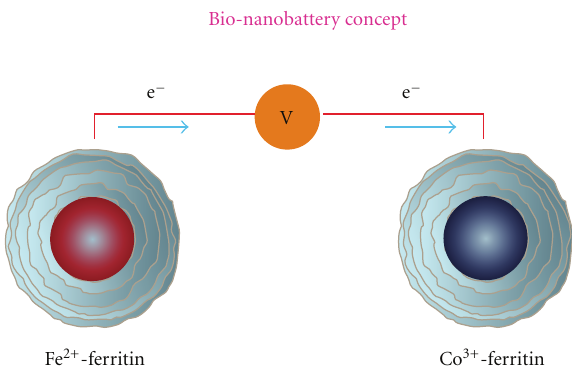
Figure 1: Schematic view of a bio-nanobattery formed from ferritin containing a Fe(OH) 2 mineral core connected to a ferritin containing a Co(OH) 3 mineral core. The cutout view shows the mineral cores within each ferritin type. The ferritin battery components are immersed in bu ff er, which is typically 0.05M pH 7.0–9.0 containing 0.10 M